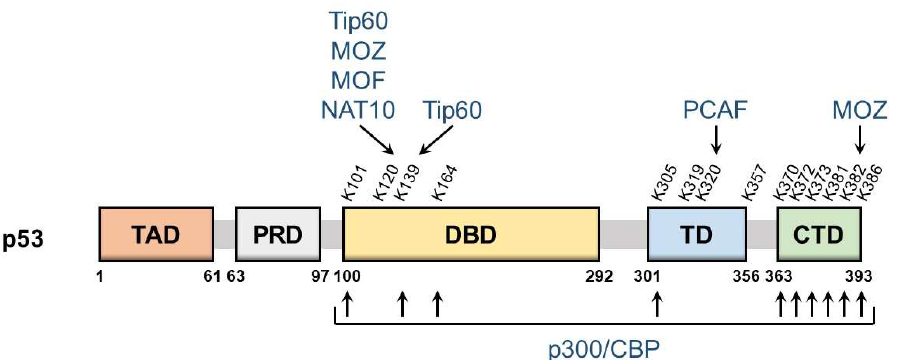
Figure 1. Schematic of p53 domains and acetylation sites. The domain structure of p53 and major p53 acetylation sites are shown above. They are: TAD, transactivation domain; PRD, proline-rich domain; DBD, DNA-binding domain; TD, tetramerization domain; CTD, C-terminal domain. The corresponding modifying enzymes are also indicated.